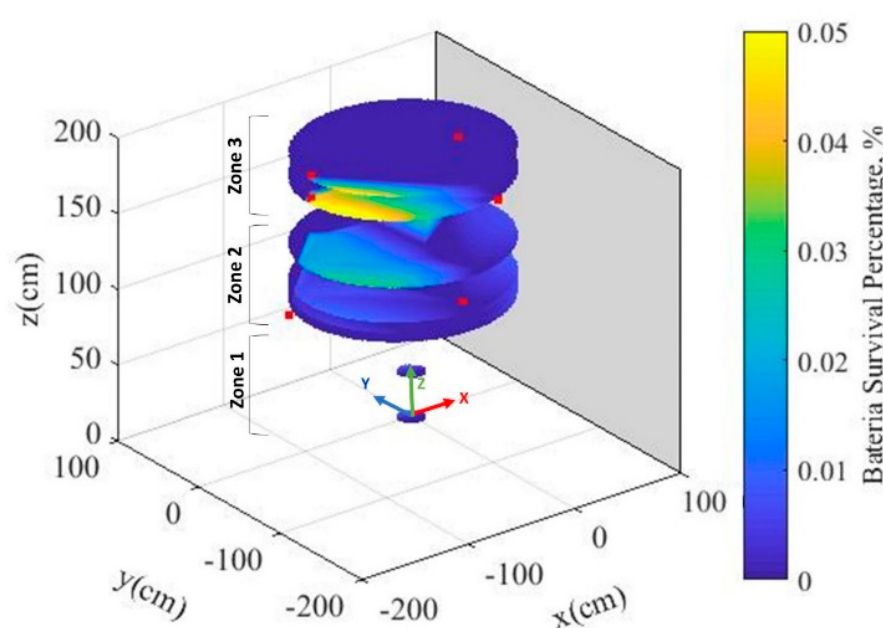
Figure 5. 3D graph of biosensor survival rate based on the locations within the canopy on the target tree (red dots indicate visible biosensors).